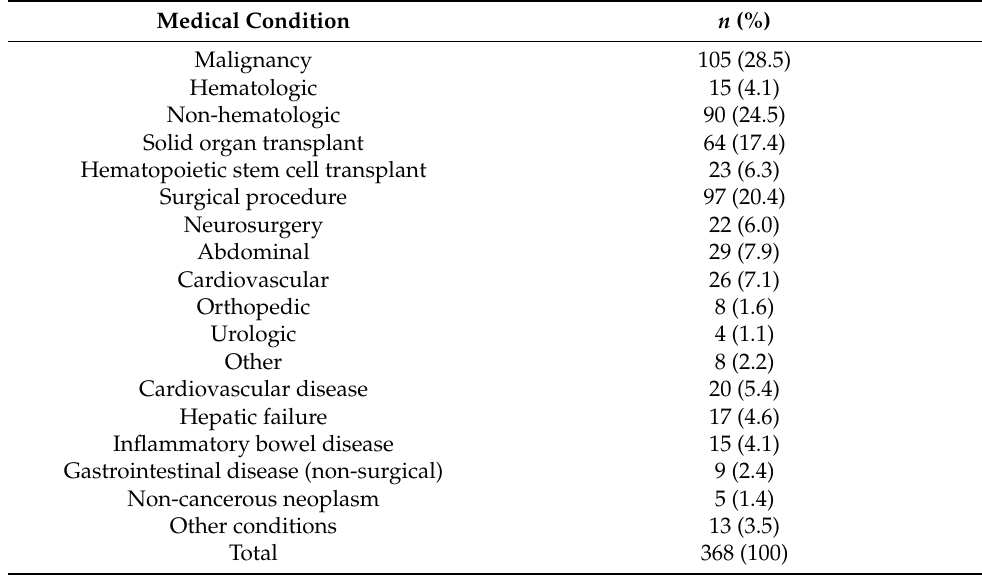
Table 1. Underlying medical conditions of hospitalized adult patients with positive C. difficile PCR included in this